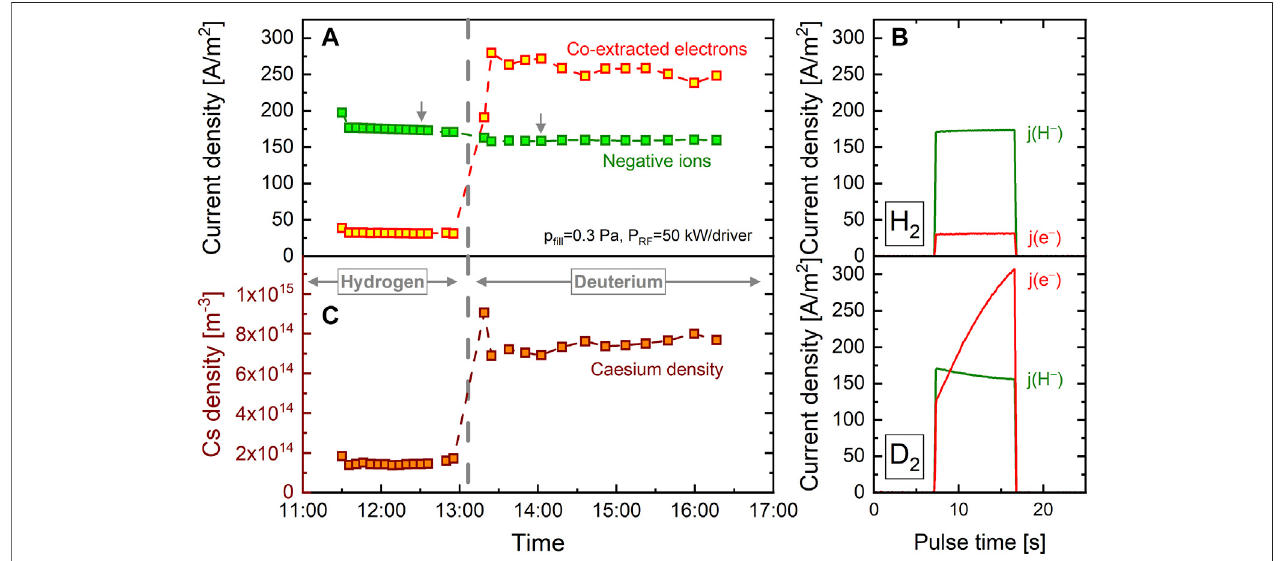
FIGURE 10 | Signals taken during one operational day when switching from H 2 to D 2 for identical source parameters. (A) Extracted negative ion current and co- extracted electron current. (B) Time traces of the negative ion current density and the co-extracted electron current density in hydrogen and deuterium. (C) Density of neutral Cs particles close to the plasma grid surface evaluated by